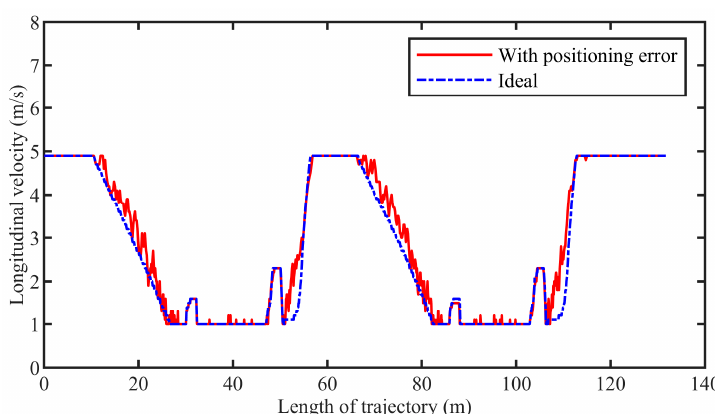
Figure 19. The longitudinal velocity of the simulation with positioning errors.